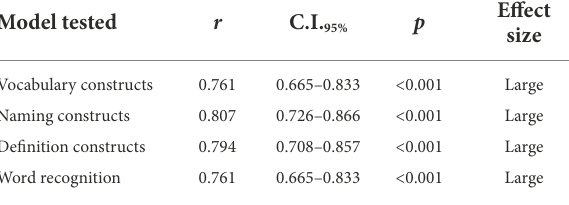
TABLE 2 Correlations between Logometro and relevant constructs as evidence of convergent